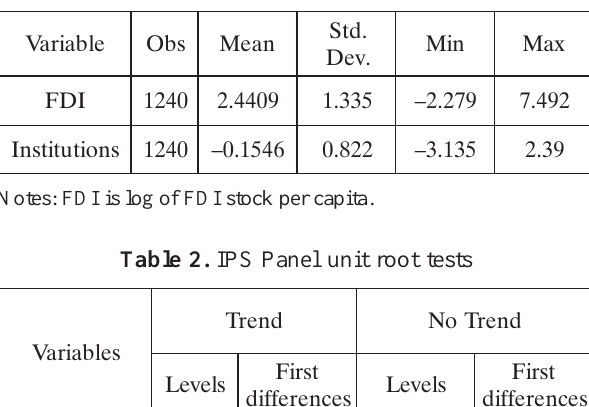
Table 1. Summary Statistics